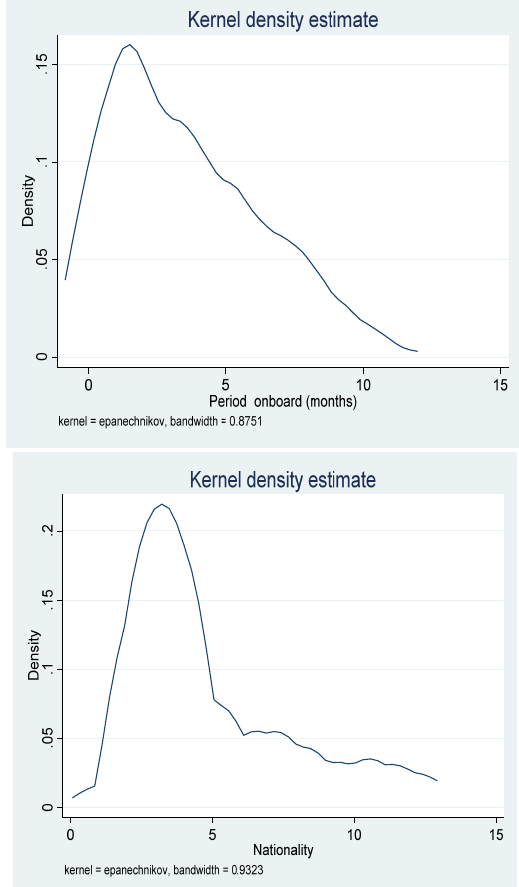
Figure 2. ( a ) Panel evolution of specific variables—parts of body injured. ( b ) Panel evolution of specific variables—period on board. Source: Own data process in Stata. To observe the distribution of our data/the main indicators used in the empirical analysis and to observe whether the data follow a normal distribution, we designed Ker- nel density estimates per each indicator, as presented in Figure 3.